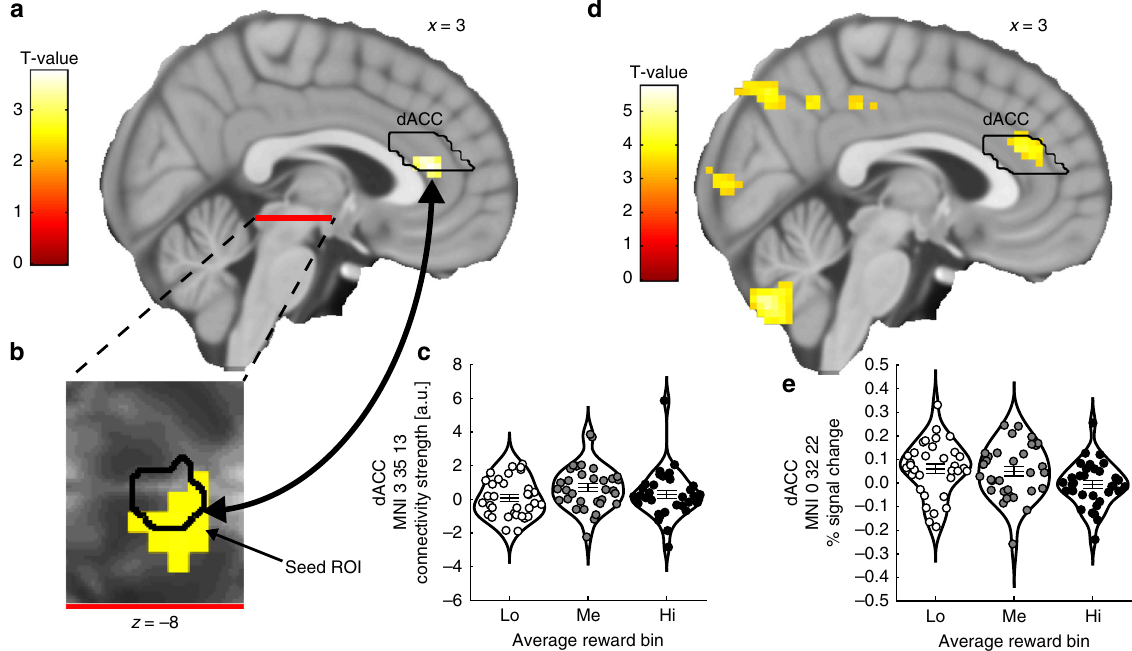
Fig. 5 VTA – dACC functional connectivity and dACC BOLD signal as a function of the average reward level. a Functional connectivity between the VTA seed ROI (see b , same fi gure for a zoomed-in display of the VTA seed ROI) and the dACC was nonlinearly modulated by average reward levels (see c , same fi gure for extracted beta parameters). b Zoomed-in display of the VTA seed ROI. c Nonlinear modulation (inverted U-shape) of VTA – dACC functional connectivity by average reward levels. d , e BOLD signal in the dACC decreased monotonically with average reward levels. The violin plots show the average strength of functional connectivity ( c ) and average % signal change ( e ) extracted from 3-mm spheres centered on the peak voxel coordinates within the dACC ROI in a and d , respectively. The horizontal lines indicate mean ± SEM. Activations are shown using an uncorrected threshold of p < 0.001. dACC dorsal anterior cingulate ROI. Source data are provided as a Source Data fi le. T-statistics were obtained from t